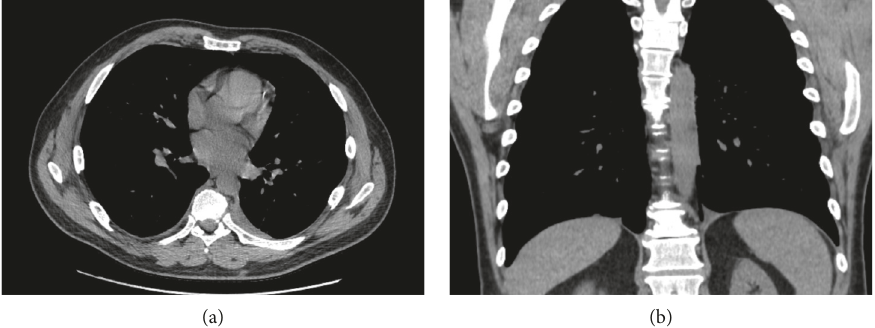
Figure 5: Repeat CT demonstrating resolution of hydropneumothoraces in the (a) axial and (b) coronal views.